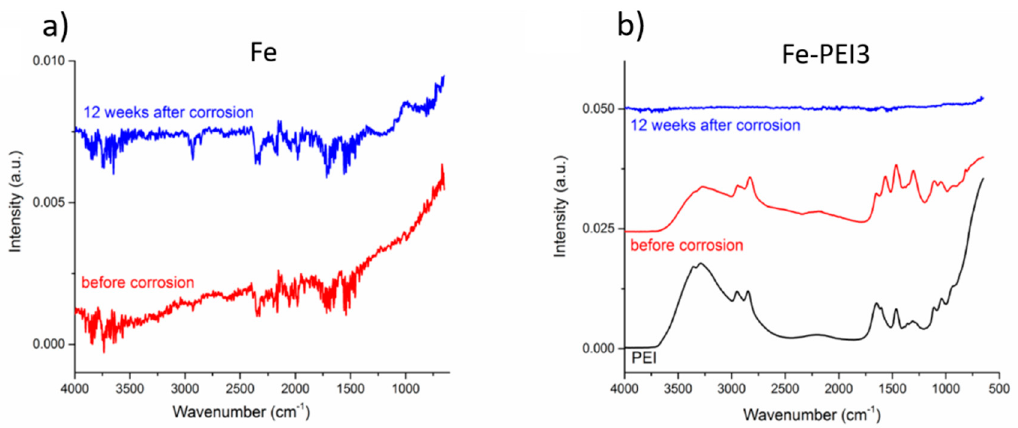
Figure 12. FT-IR spectra of ( a ) pure Fe; ( b ) Fe-PEI3 after 12 weeks of corrosion in Hanks’ solution. Spectrum of pure PEI is added for better comparison.